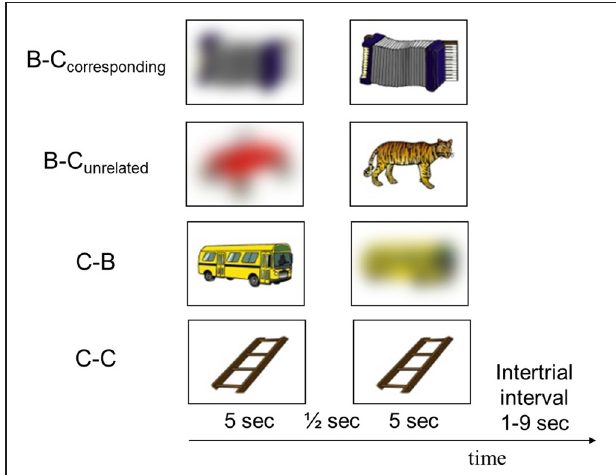
FIGURE 1 | Examples of pictures presented in each of the four conditions. The experiment consisted of 35 trials from each condition, presented in pseudorandom